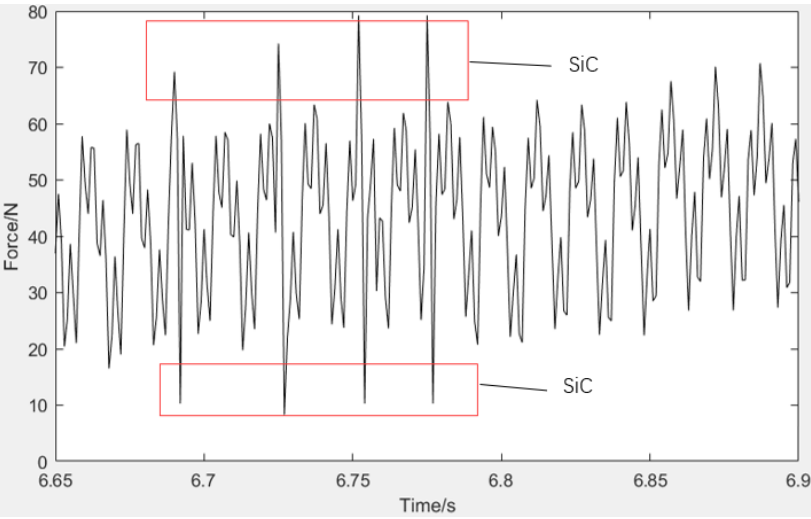
Figure 5. Variation curve of milling force under a single milling path.